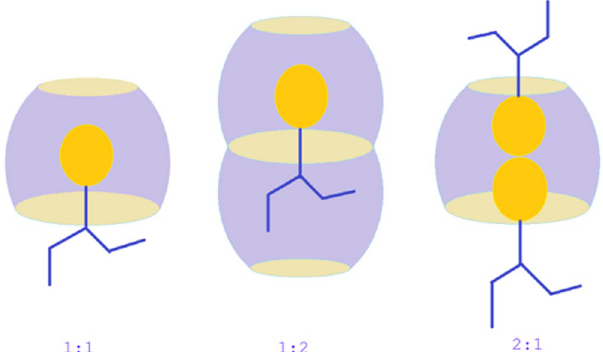
Figure 3. Probable host:guest stoichiometric ratio of the inclusion complexes.